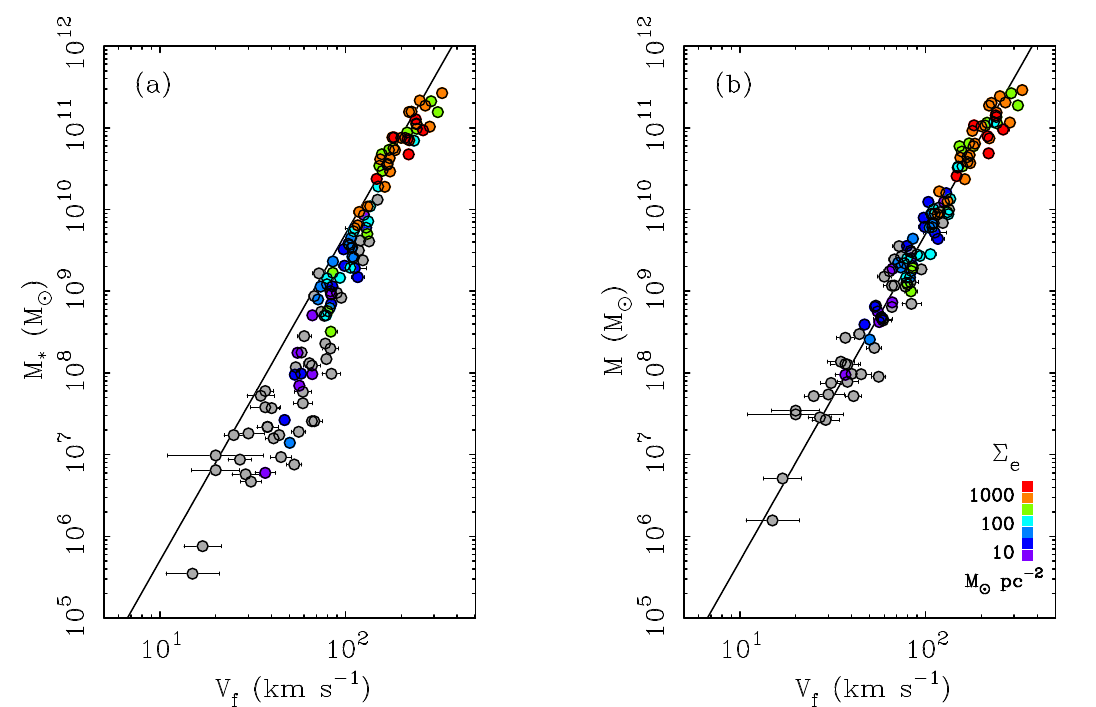
Figure 1. Tully–Fisher relations: the flat rotation speed V f as a function of ( a ) stellar mass, and ( b ) baryonic mass ( M = M ∗ + M g ). Gas masses follow from observed 21cm fluxes [60]. Stellar masses are estimated from observed luminosities and a population synthesis prescription for the stellar mass-to-light ratio: M ∗ = Υ ∗ L [48]. Here, and throughout the paper unless otherwise noted, we adopt Υ ∗ = 0.5 M (cid:12) /L (cid:12) for star forming disks and 0.7 M (cid:12) /L (cid:12) for bulge components in the 3.6 µ band (often called [3.6]) of the Spitzer Space Telescope [47,61,62]. Rotation speeds are obtained from resolved rotation curves that are extended enough to measure V f [37,42,55]. Points are color coded by the effective stellar surface density when known from Spitzer data [29,49], ranging from low (blue) to high (red) surface brightness (scale inset). The gray points are gas dominated low surface brightness (LSB) galaxies that meet the quality criteria discussed by [55] but do not have Spitzer data. The line is the prediction of MOND [16] for the value of a 0 found by [33] before these data